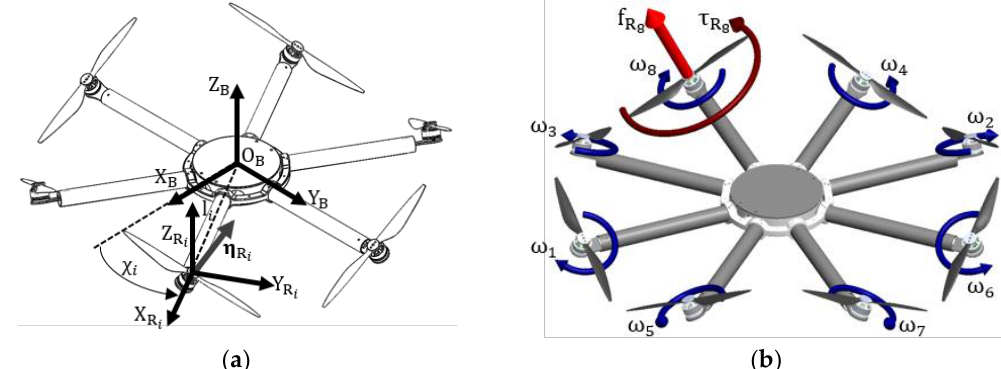
Figure 2. Schematic representation of the multirotor UAV configuration: ( a ) multirotor configuration (propulsion) reference coordinate systems; ( b ) schematic representation of the propulsion system.